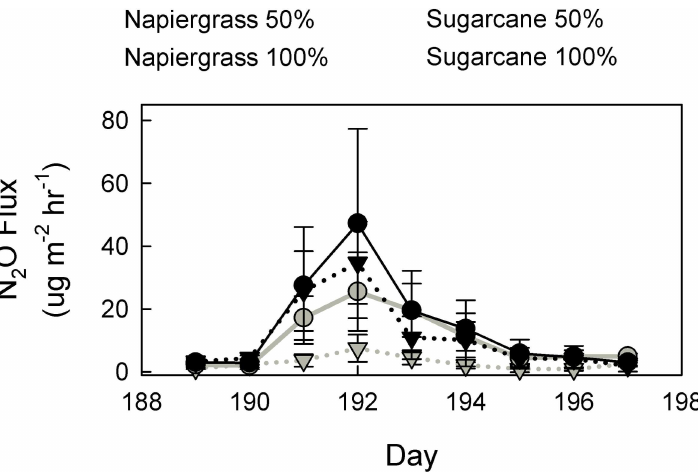
Fig 3. N 2 O flux increasesafter fertilization. N 2 O flux followingfertilization; values are means ( ± one